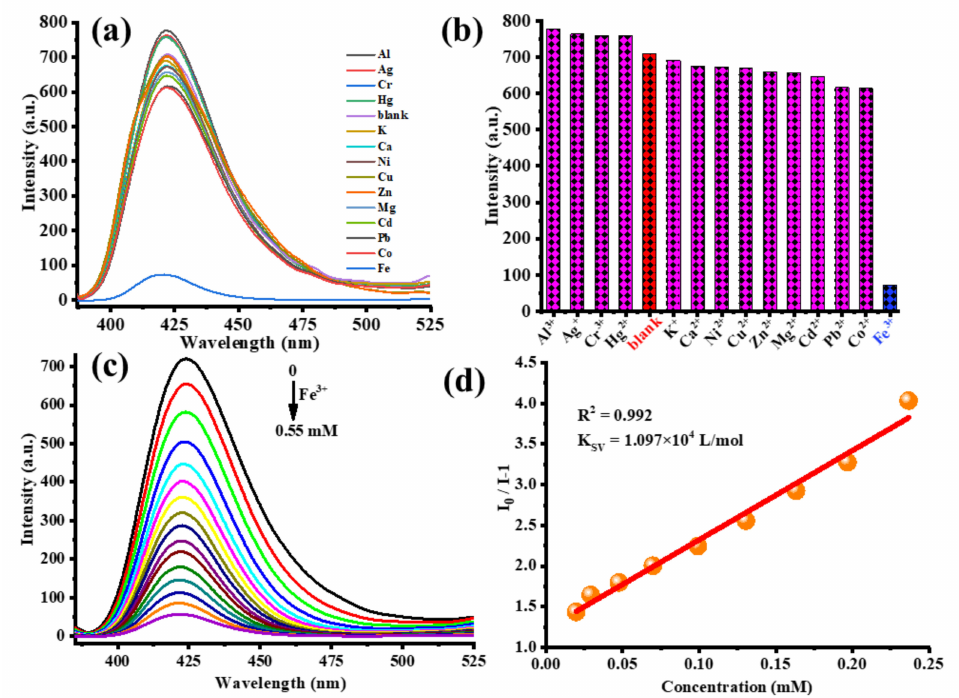
Figure 10. ( a ) Photoluminescence spectra of 1 in water and aqueous solutions containing different metal ions (1 × 10 − 3 M) when excited at 376 nm. ( b ) The photoluminescence intensities of 1 in aqueous solutions with various inorganic cations (1 × 10 − 3 M) when excited at 376 nm. ( c ) The emission spectra for 1 in aqueous solution of different Fe 3+ concentrations. ( d ) The linear relationships for 1 in aqueous solution of different Fe 3+